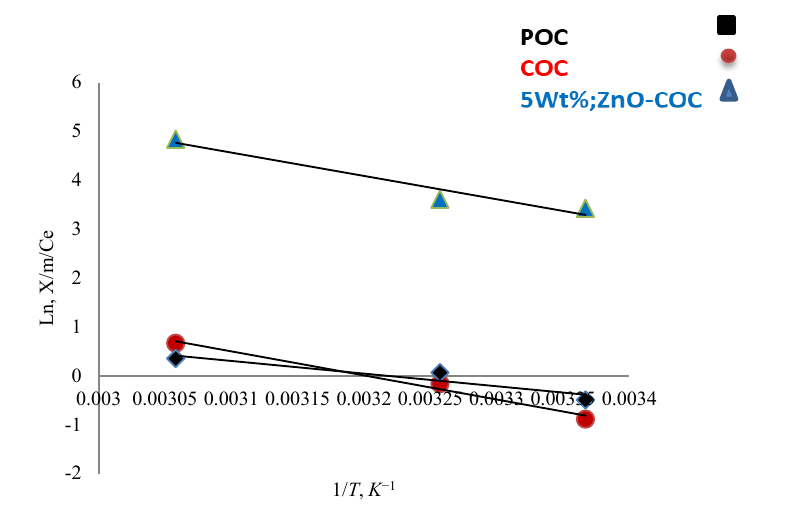
Fig. 8 . Influence of temperature on MB adsorption on (■) purified clay, (● ) calcined clay and ( ▲ ) impregnated clay (pH = 6.8; m = 0.025 g; V = 50 mL; Ci = 50 mg L − 1 ; T = 24